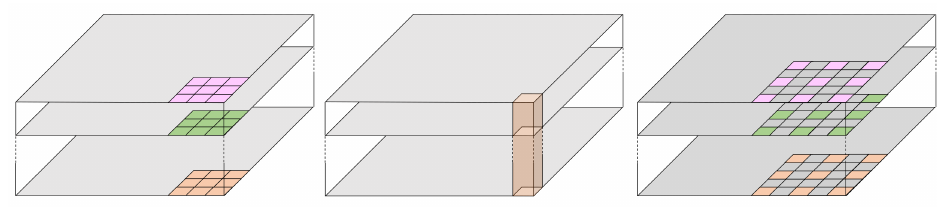
Figure 4. Illustration of the atrous separable